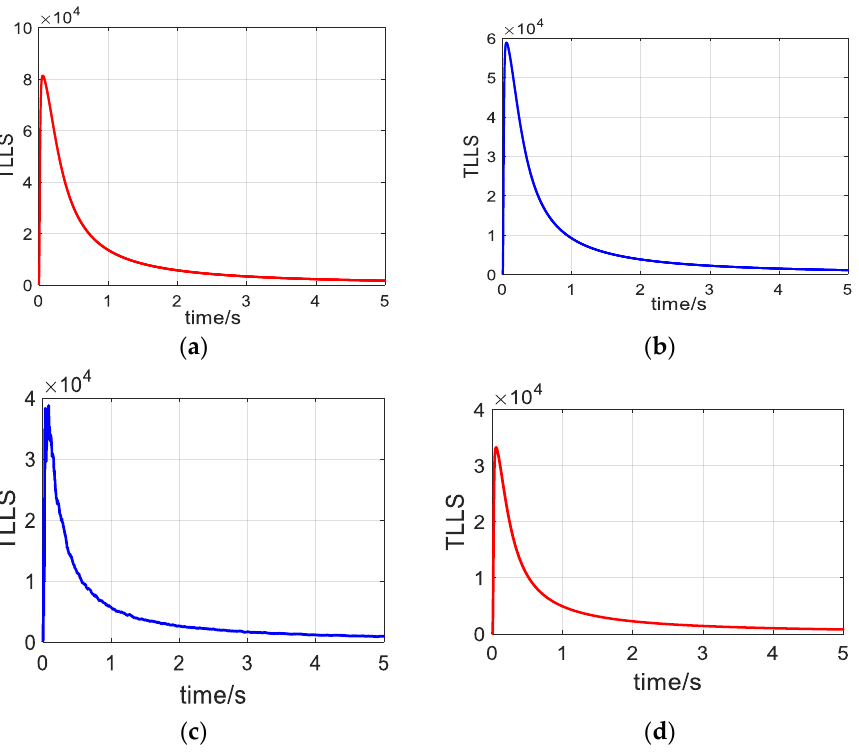
( b ) wheel 4/offline/high adhesion; ( c ) wheel 2/offline/low adhesion; ( d ) wheel 4/offline/low adhe- Figure 9. The offline estimation of longitudinal linear stiffness: ( a ) wheel 2/offline/high sion.